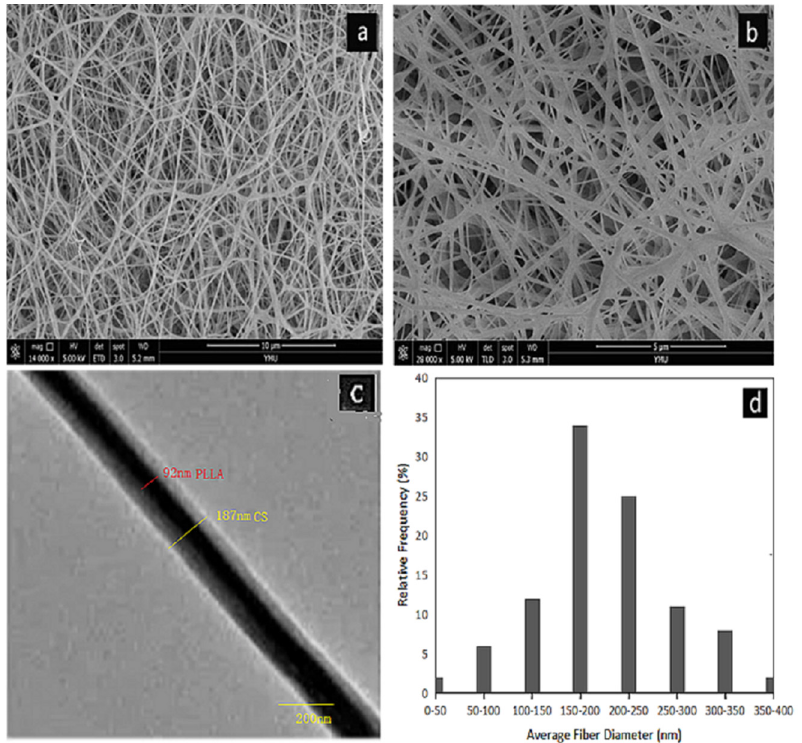
Figure 1. ( a , b ) SEM images of PLLA@CS coaxial nanofibers; ( c ) TEM images of PLLA@CS coaxial nanofibers; and ( d ) diameter distribution of PLLA@CS coaxial nanofibers;.